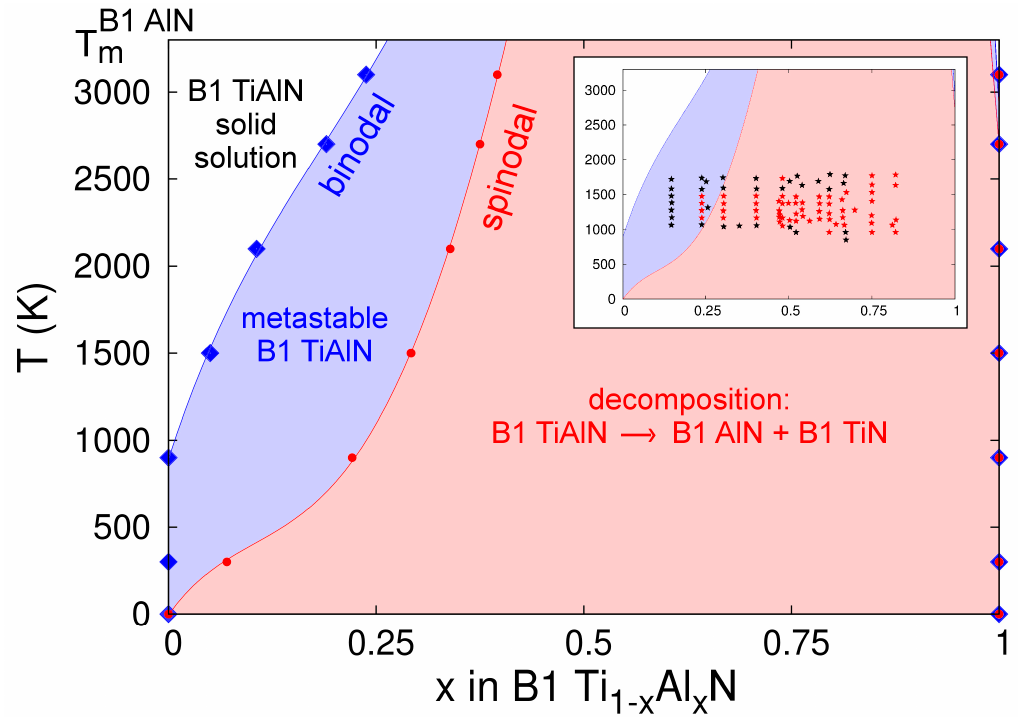
Figure 11. Spinodal and binodal curves for B1-Ti 1 − x Al x N solid solutions calculated using CMD free energies of mixing with respect to B1-TiN and B1-AlN. The inset compares our results to experimental data (black and red stars mark B1-Ti 1 − x Al x N and spinodally-decomposed solid solutions, respectively) collected in Ref. [138].